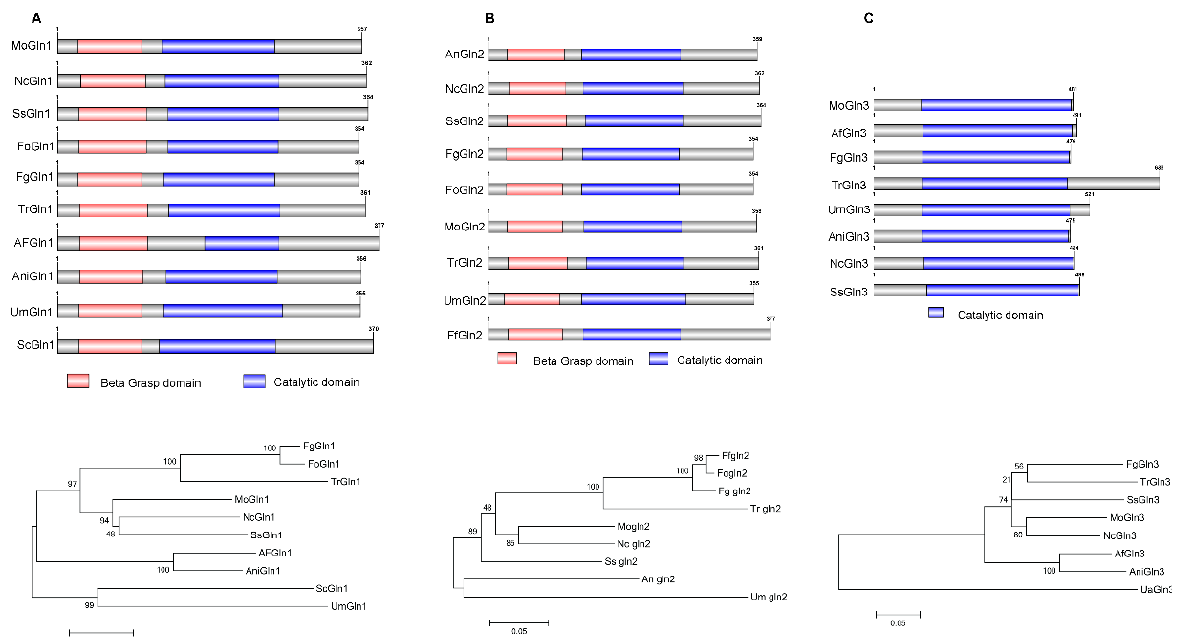
Figure 1. Domain architecture and phylogeny of M. oryzae glutamine synthetase in different fungi: ( A ) Gln1 domain architecture and maximum likelihood based phylogenetic outlook in different fungi; ( B ) Gln2 domain architecture and maximum likelihood phylogenetic analysis in fungi groups; ( C ) Domain architecture of Gln3 and the maximum likelihood phylogeny in different fungi. Maximum likelihood phylogeny for the glutamine synthetase amino acids of different fungi was tested with 1000 bootstrap replicates.